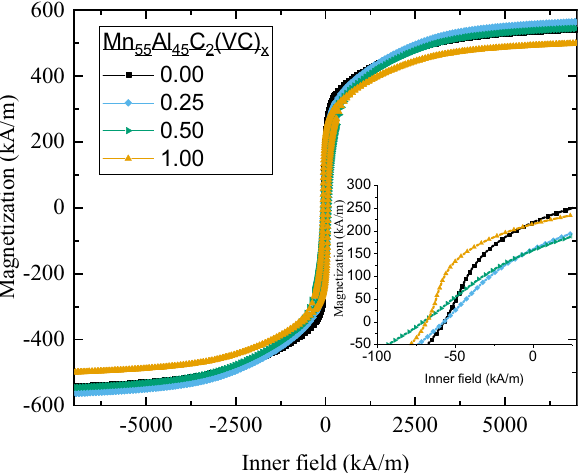
Figure 5. Magnetic hysteresis curves for Mn 55 Al 45 C 2 , Mn 55 Al 45 C 2 (VC) 0.25 , Mn 55 Al 45 C 2 (VC) 0.5 and Mn